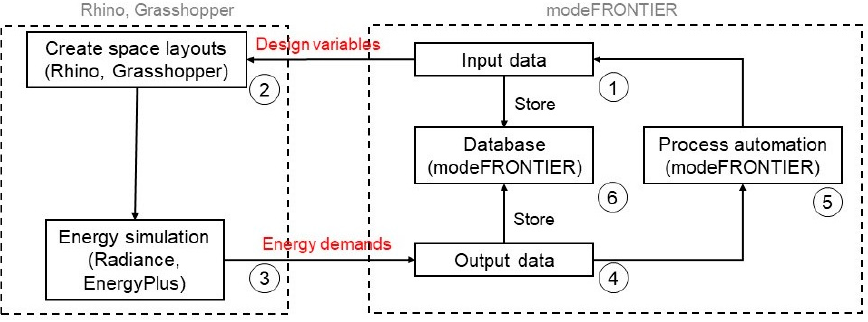
Figure 1. Workflow of the computational method for DOE and optimisation.